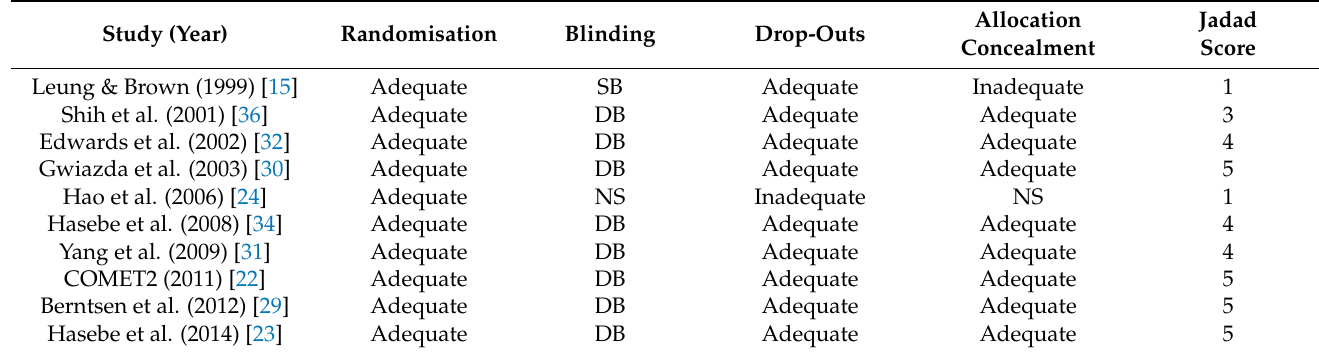
Table 2. Quality assessment of the ten progressive addition spectacle lens trials included in the meta-analysis. SB—single blind; NS—not specified; DB—double